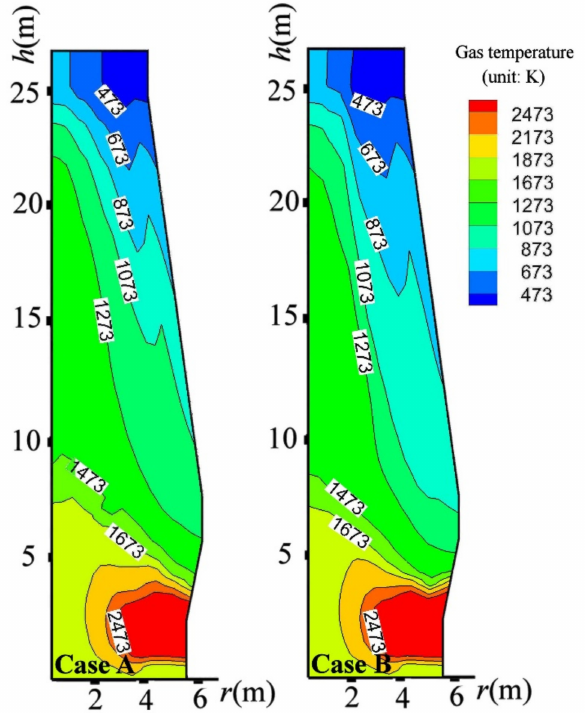
Figure 7. Profiles of gas temperature in cases A and